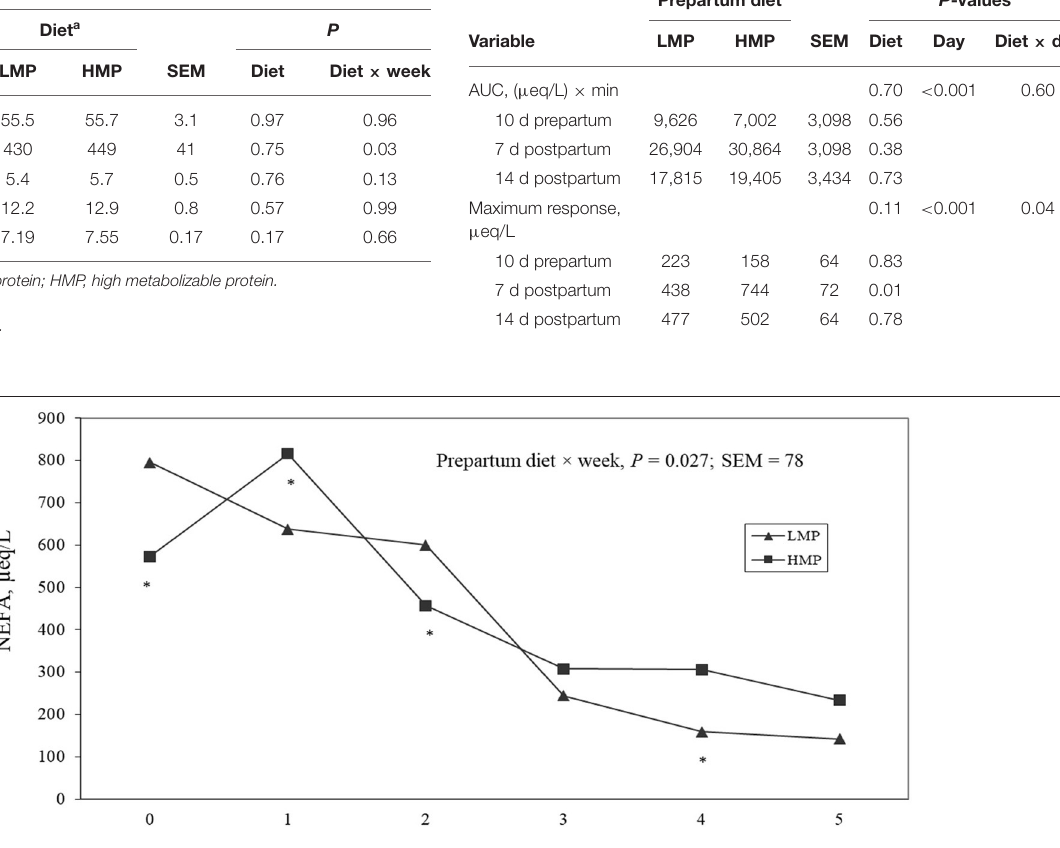
Frontiers in Animal Science |